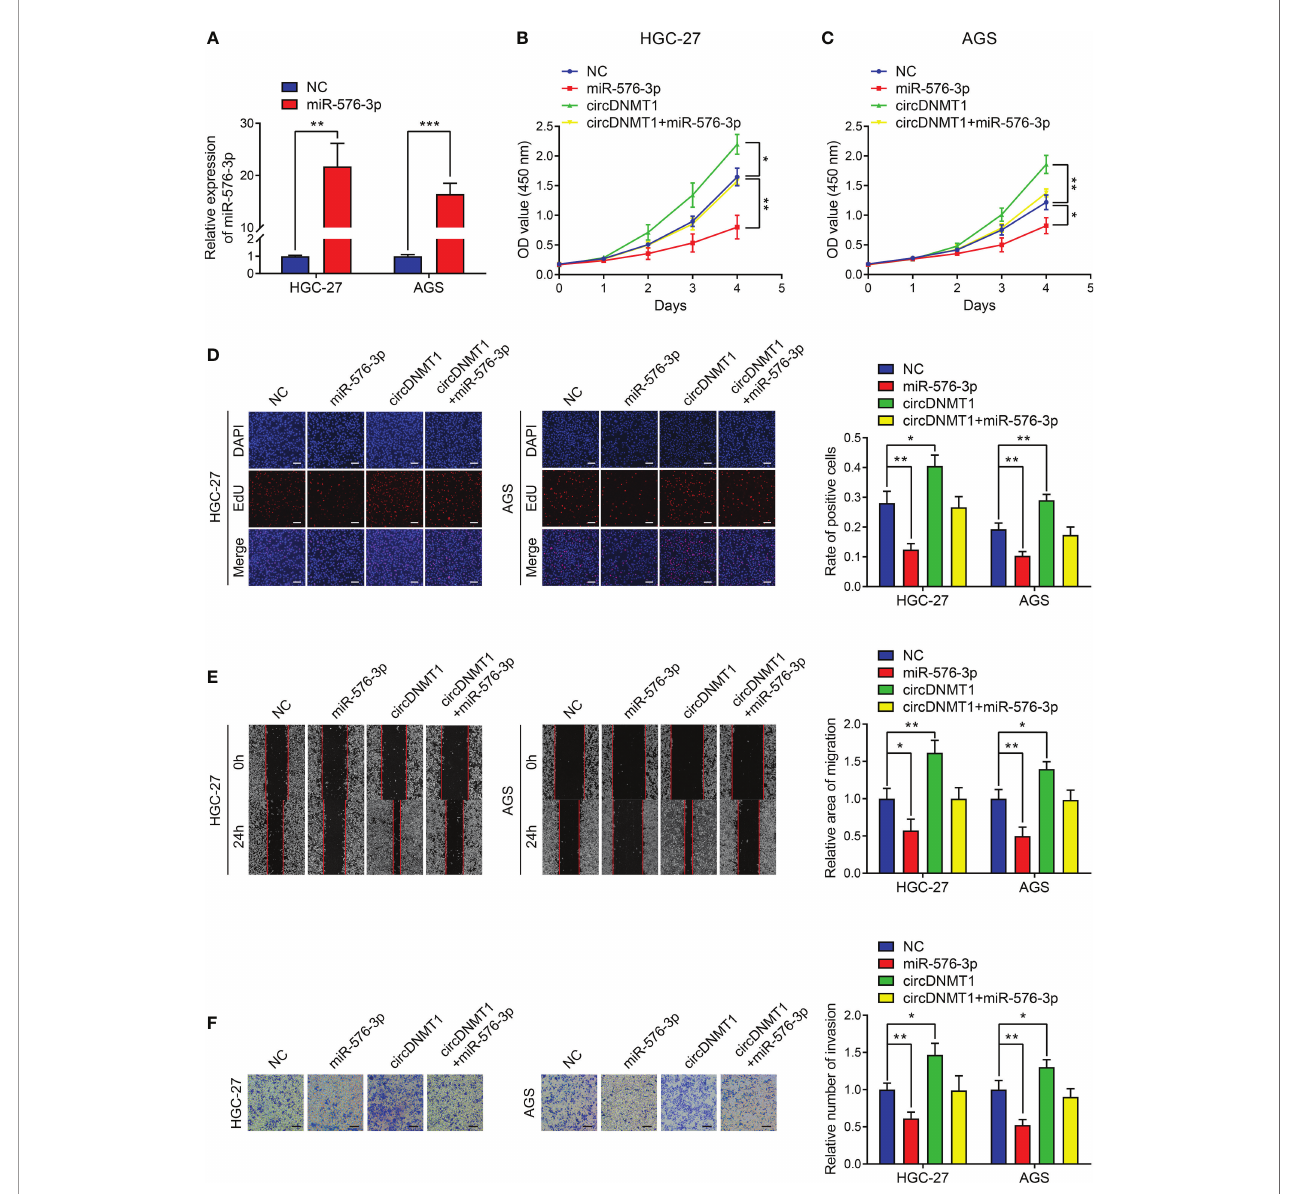
FIGURE 5 | circDNMT1 potentiates GC progression by targeting miR-576-3p. (A) qRT-PCR analysis to show the miR-576-3p expression in HGC-27 and AGS cells that were transfected with NC or miR-576-3p mimics. (B, C) The CCK-8 assay to show proliferation of HGC-27 (B) and AGS (C) cells stably carrying lentivirus with vectors or circDNMT1 overexpression plasmids and additionally transfected with NC or miR-576-3p mimics. (D) The EdU assay to show proliferation of cells as in (B-C). Scale bar: 100 m m. The histogram is displayed on the right. (E) The wound healing assay to show migration of cells as in (B, C) . The histogram is displayed on the right. (F) The transwell assay to show invasion of cells as in (B, C) . The histogram is displayed on the right. Scale bar: 100 m m. Data were presented as means ± SD. *P < 0.05, **P < 0.01, ***P <